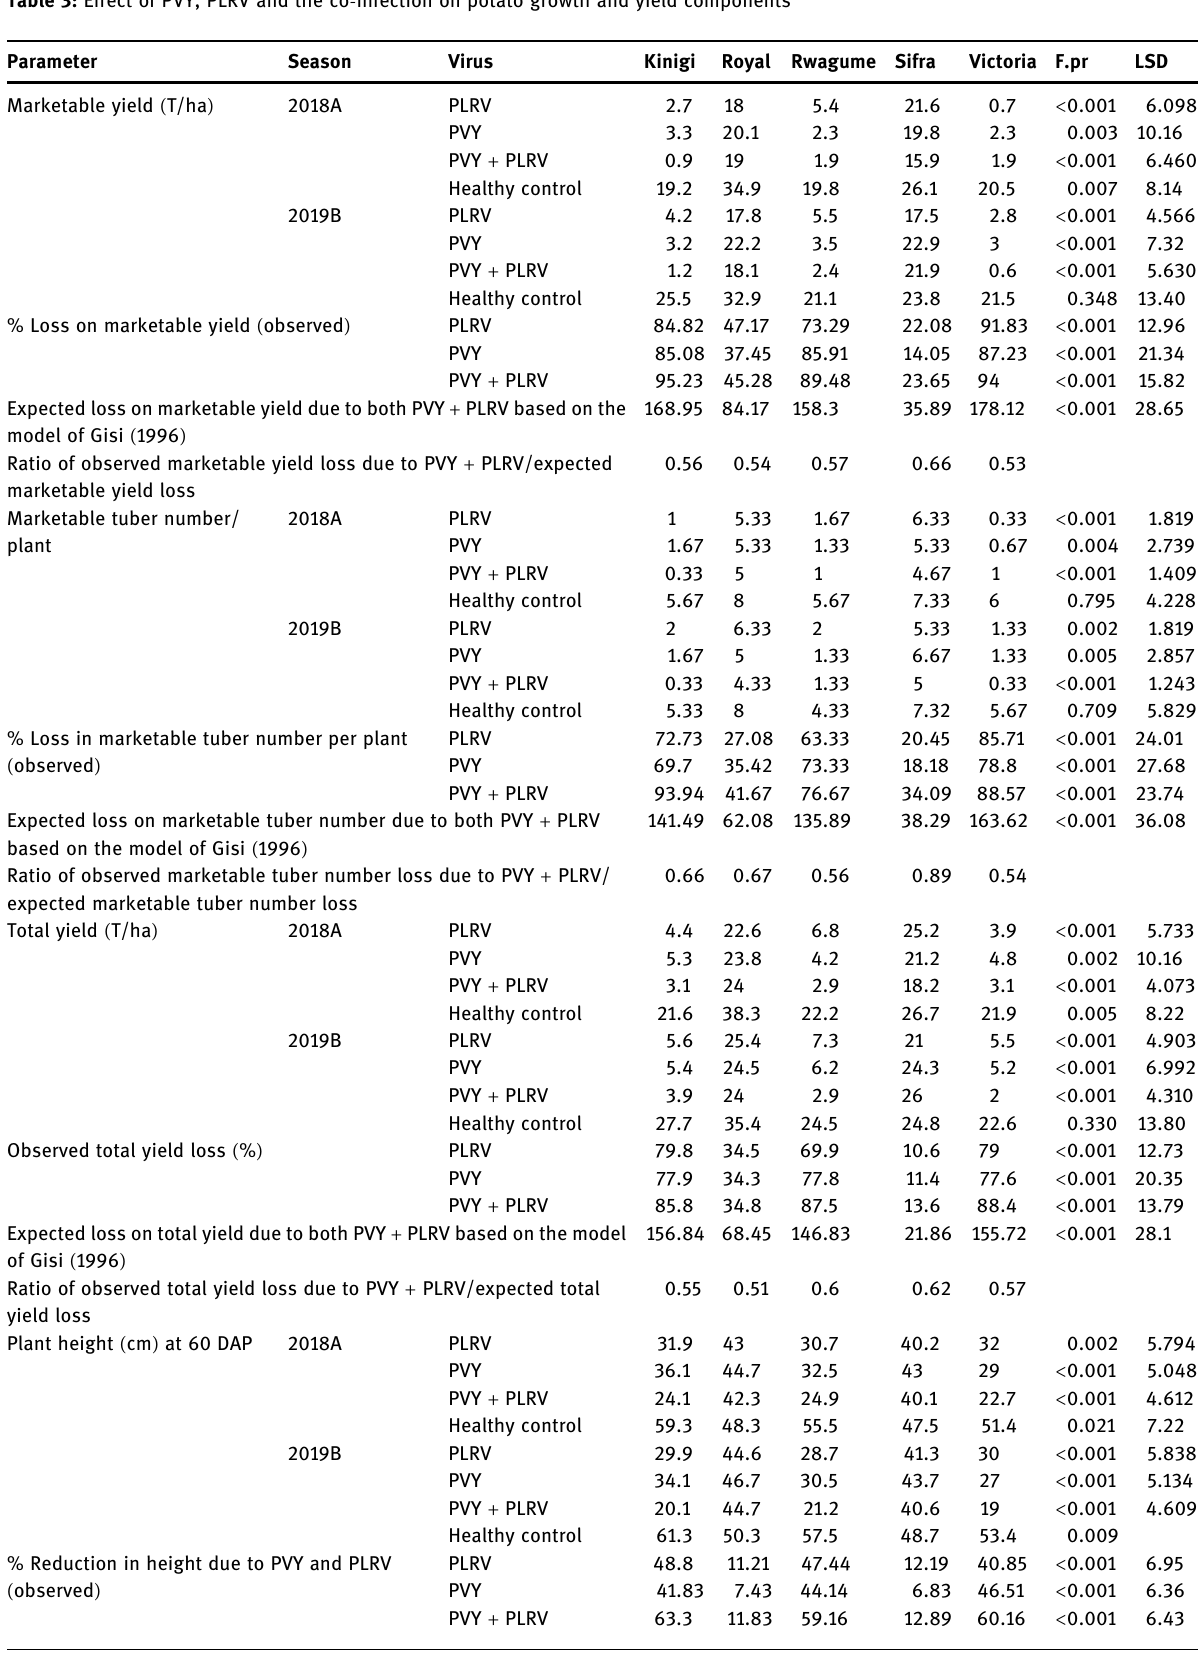
Table 3: E ff ect of PVY, PLRV and the co - infection on potato growth and yield components